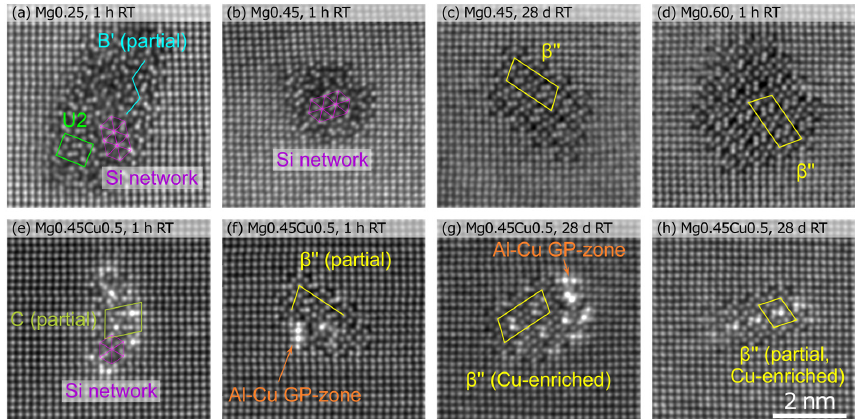
Figure 7. HAADF-STEM images of precipitates from the same conditions as in Figure 6. The structures are representative of the two classes of alloys (Cu-free and Cu-containing). ( a , b ) Disordered, ( c , d ) β′′ , ( e ) L [38], ( f – h ) Cu-containing β′′ . Alloy Mg0.45Cu0.5 hosts precipitates containing Cu-rich columns, which appear